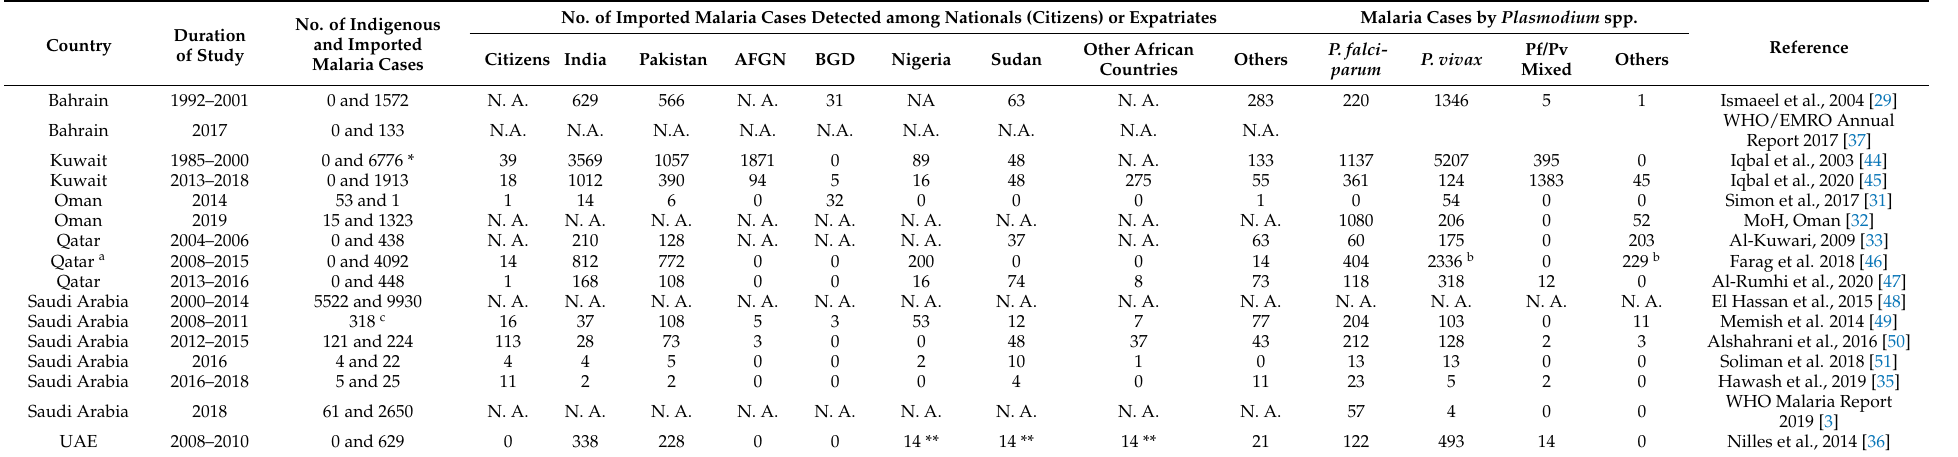
Table 2. Indigenous and imported malaria cases reported in different recent studies from the GCC